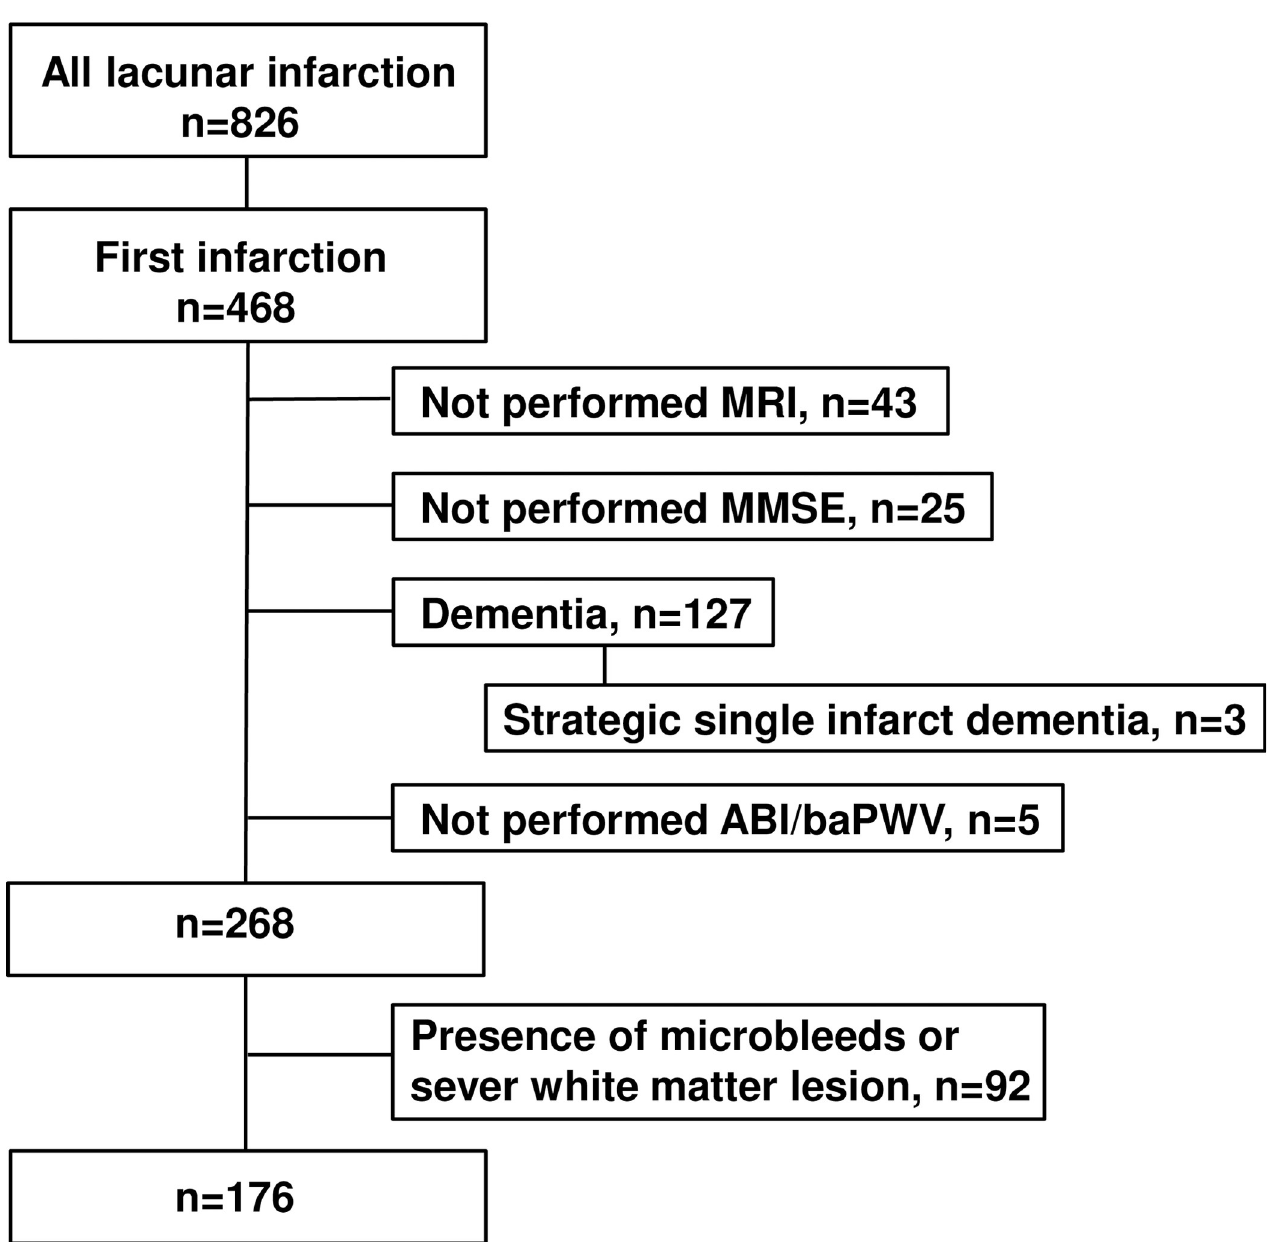
Fig 1. Flow chart of the inclusion and exclusion criteria. MRI, magnetic resonance imaging; MMSE, Mini-Mental State